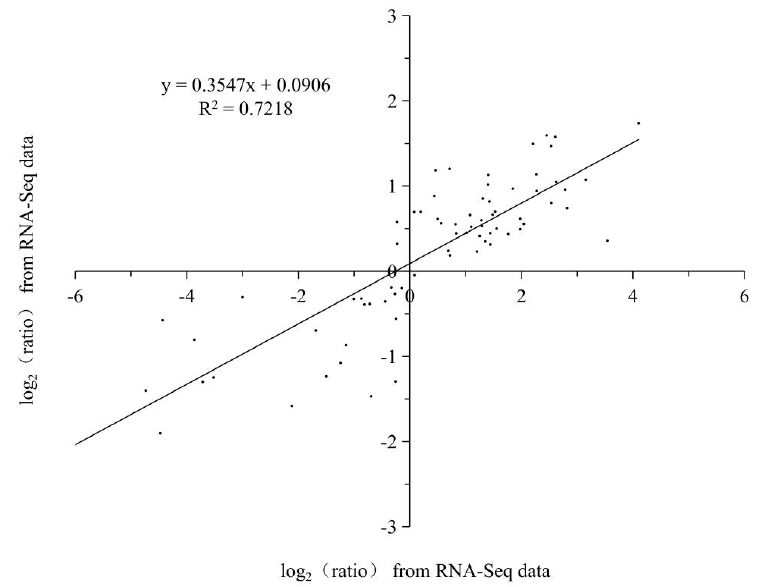
Figure 11. Coefficient analysis of fold change data between qRT ‐ PCR and RNA ‐ Seq. All the data are from the qRT ‐ PCR analysis and RNA ‐ Seq of the 0 d (C0d), 4 d (L4d), 8 d (L8d), and 12 d (L12d). Scatterplots were generated by the log2 expression ratios from RNA ‐ seq ( x ‐ axis) and qRT ‐ PCR ( y ‐ axis).